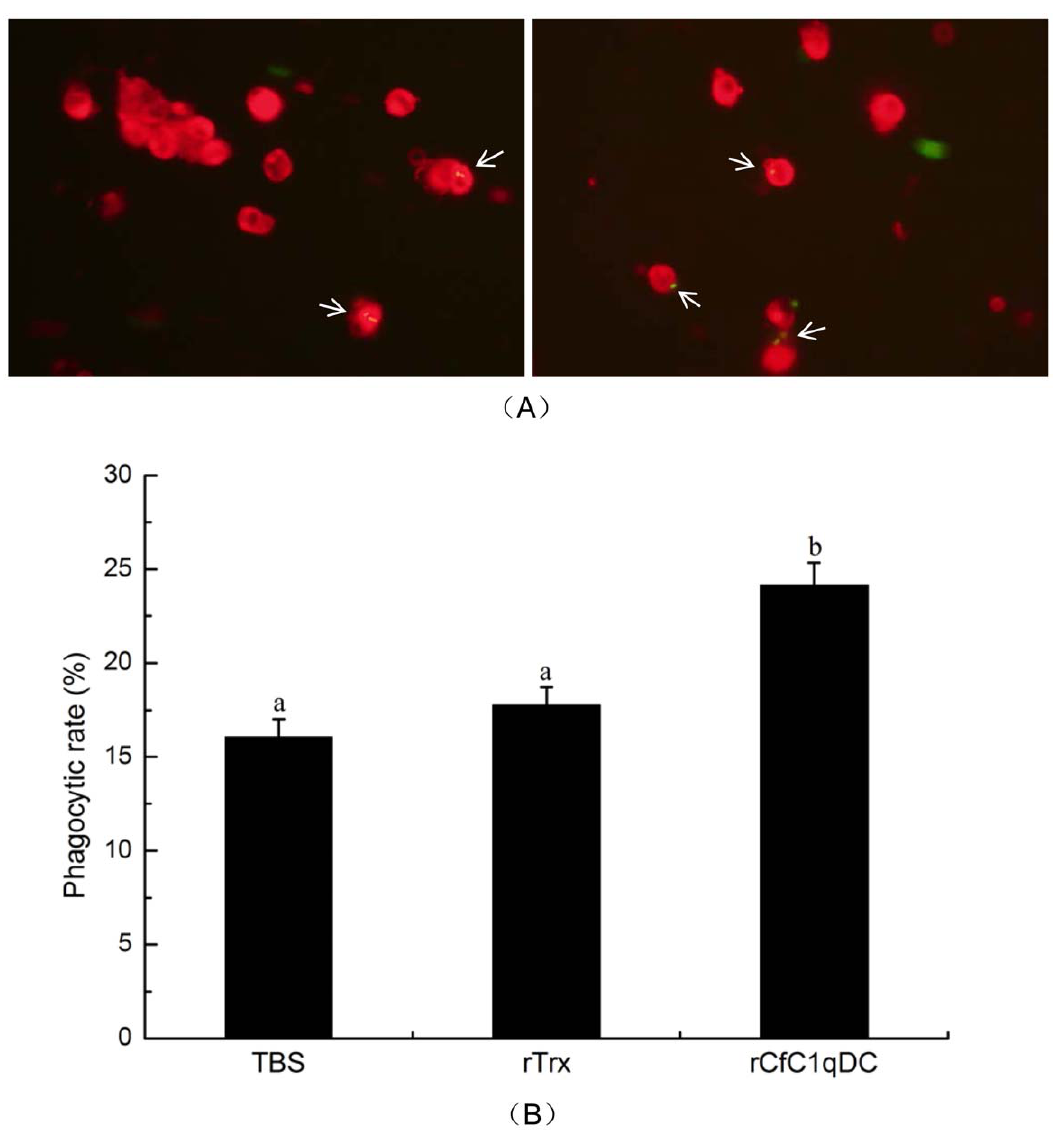
Figure 8. Phagocytosis enhanced by rCfC1qDC. The hemocytes were resuspended with TBS buffer, rTrx in TBS buffer and rCfLec-1 in TBS buffer, respectively. Then E. coli was added into each hemocytes suspension for 45 min. The mixture was mounted onto a glass slide and incubation for 30 min to allow attachments of hemocytes to form a monolayer. After the fluorescence of nonphagocytosed bacteria was quenched by the trypan blue, hemocytes on each slide were counted (A). Phagocytic rate (PR)=(phagocytic hemocytes)/(total hemocytes) 6 100% (B). For each treatment, assay was performed in four different slides for statistic analysis. Bar =10 m m.